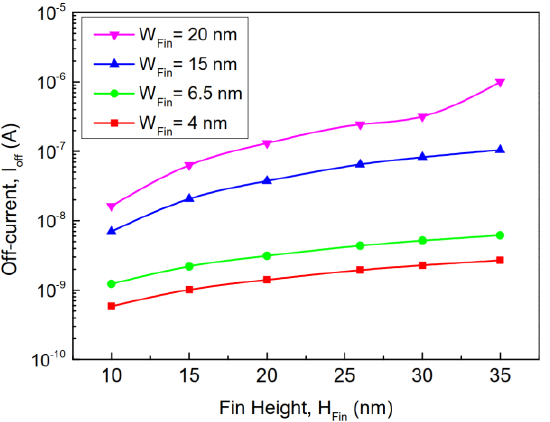
Figure 10. Behavior of the leakage current as a function of fin height for FinFET devices with different values of the fin width at V gs = 0 V and V ds = 0.8 V.